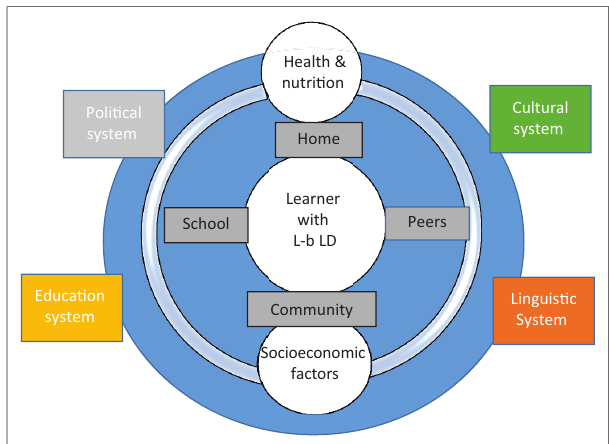
FIGURE 2: The system of language-based learning difficulties.